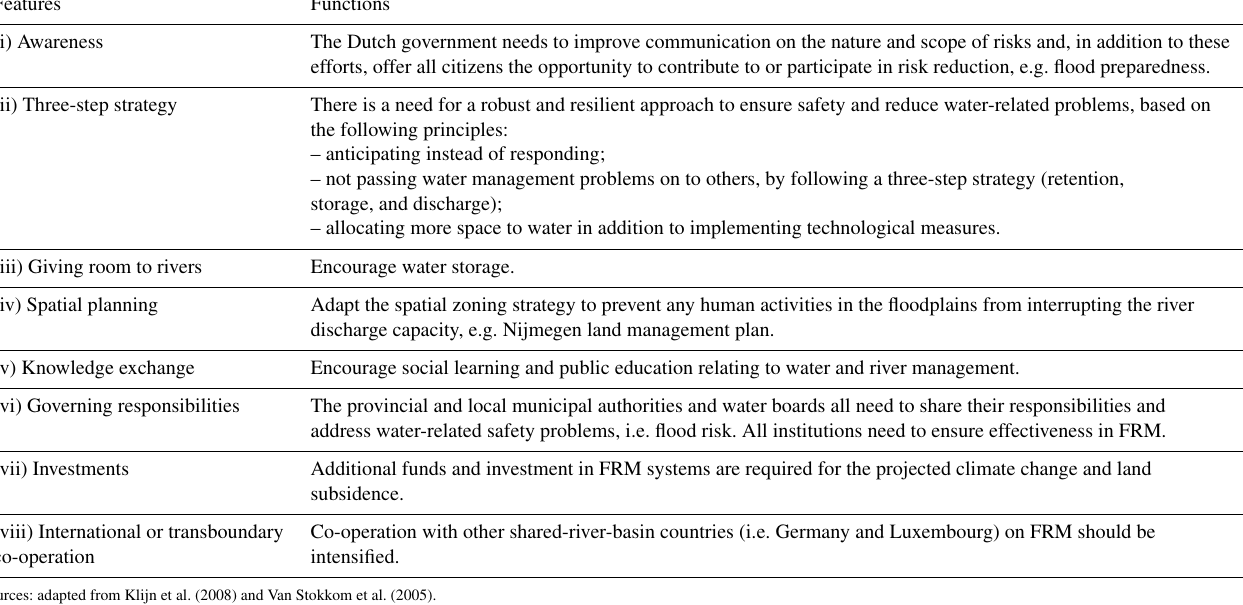
Table 1. Features and functions of the Room for the River policy in the Netherlands. Features